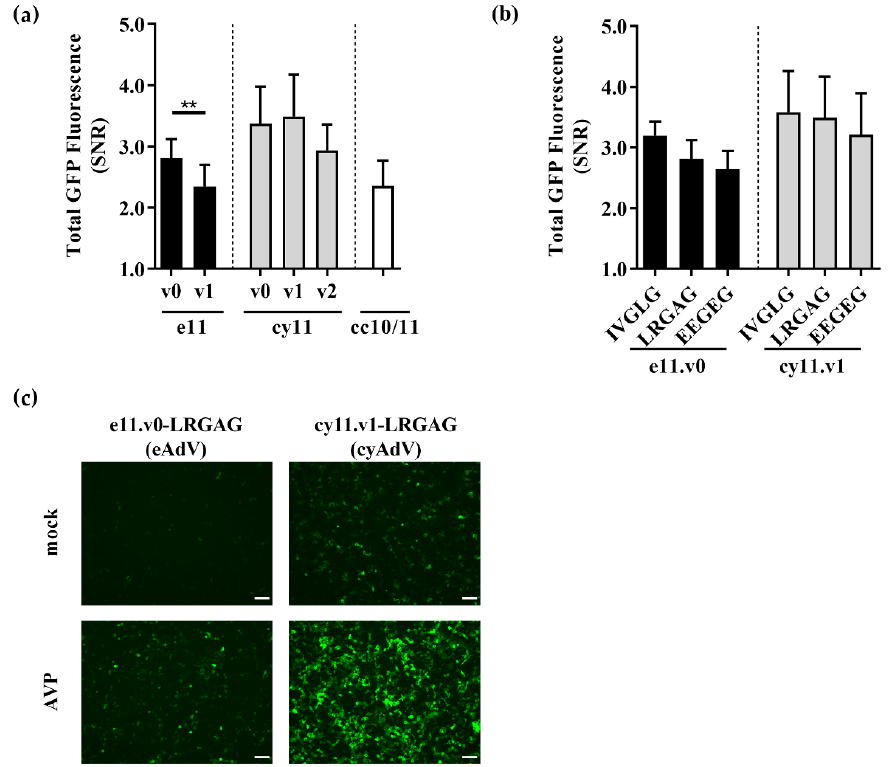
Figure 2. Evaluation of the different sensors and the impact of backbones and cleavable sequences on sensor performance for detection of adenoviral proteolytic activity. Sensor performance as given by GFP signal-to-noise ratio (SNR) of ( a ) different backbones for e11, cy11, and cc10/11 strategies with a LRGA*G cleavable sequence, and ( b ) different cleavable sequences in the optimal e11.v0 and cy11.v1 backbones were assessed by flow cytometry 48 h after transient co-transfection. Data shown as mean ± SD of at least three independent experiments. **, p < 0.01 as given by an unpaired, two-tailed Students’ t -test. ( c ) Fluorescence microscopy of e11.v0-LRGAG (eAdV) and cy11.v1-LRGAG (cyAdV) sensors 48 h after co-transfection with GFP10 and a mock plasmid or AVP-coding plasmid. Scale bar = 100 µm.